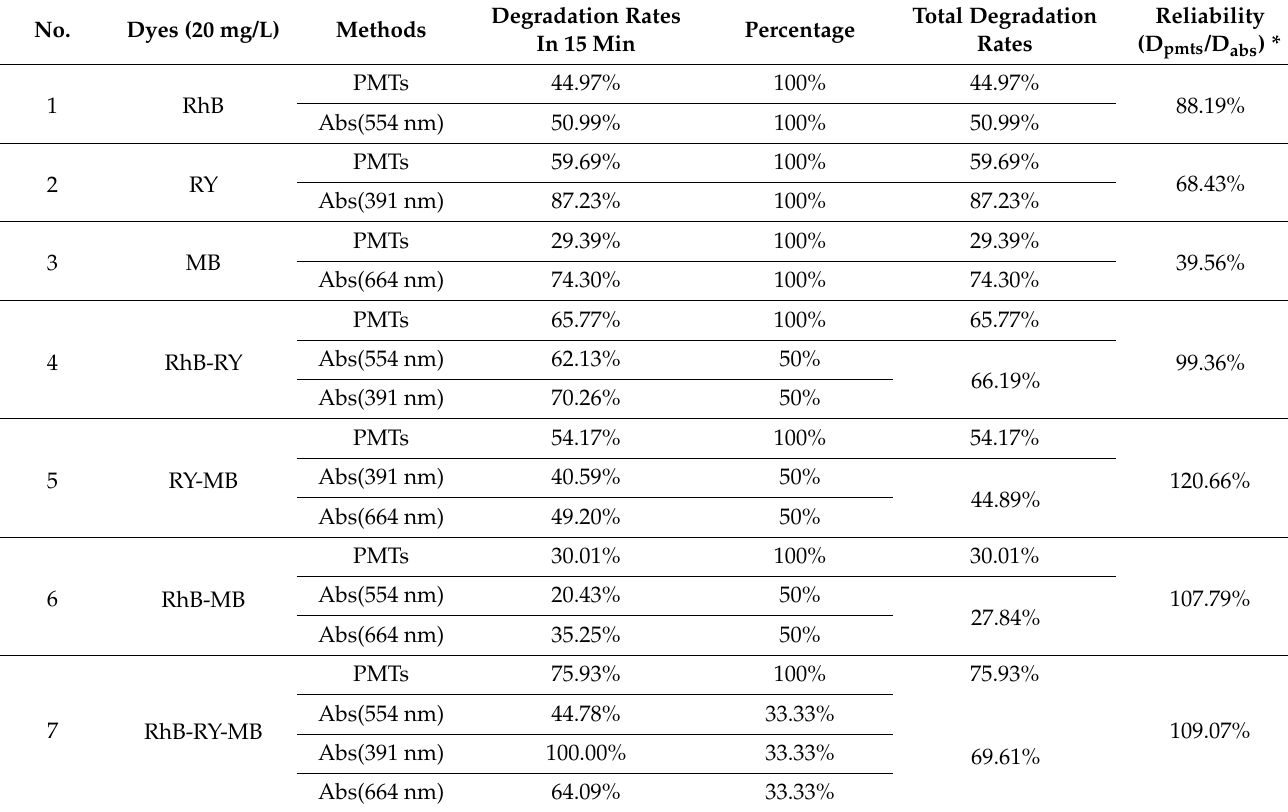
Table 3. Comparison between the results of the PMTs method and the absorbance (Abs) method for the photocatalytic degradation of different dye